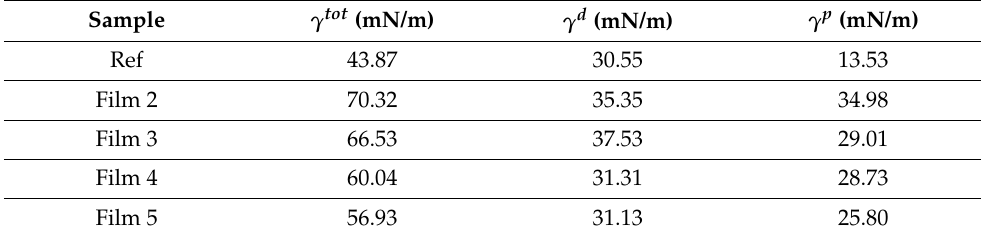
Table 2. Total surface free energy and its polar and dispersed